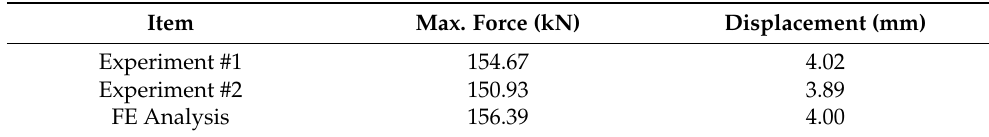
Table 5. Results of finite element analysis.